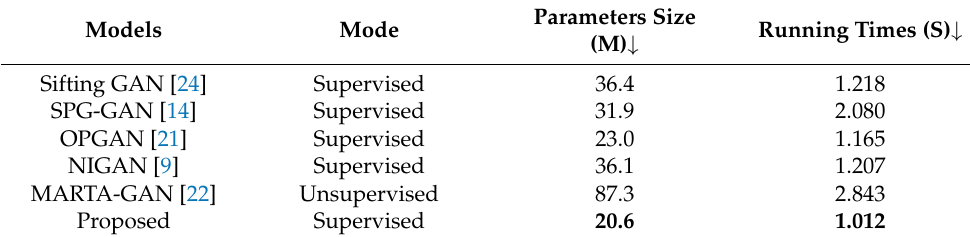
Table 5. Comparison of model parameter size and running time.